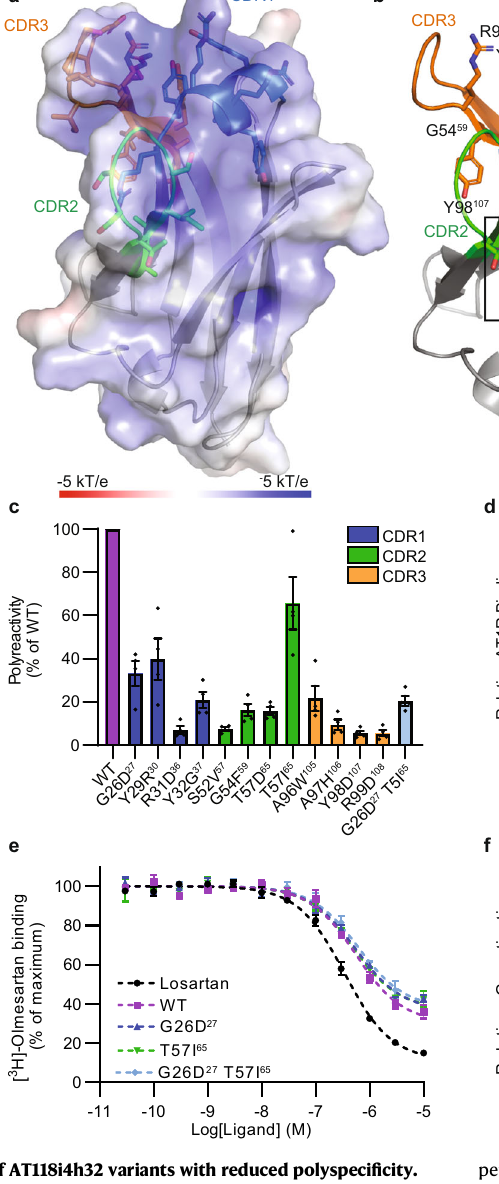
performed in technical triplicate, error bars are shown as SEM. e Radioligand competition binding of AT118i4h32 variants or the small molecule antagonist losartan and [ 3 H]-olmesartan to AT1R in cell membranes. Like WT AT118i4h32, the G26D 27 , T57I 65 , and G26D 27 T57I 65 variants compete with olmesartan for binding to the AT1R. Data in e is the average of three independent experiments performed in technical triplicate, error bars are shown as SEM. f Suppression of Gq-mediated inositol monophosphate production by AT118i4h32 in response to AngII stimula- tion. HEK293 suspension cells expressing FLAG-AT1R were treated with 5 μ M AT118i4h32 or no nanobody prior to AngII stimulation. Data in d is the average of three independent experiments performed in technical triplicate, error bars are shown as SEM. K i values are reported in Supplementary Table